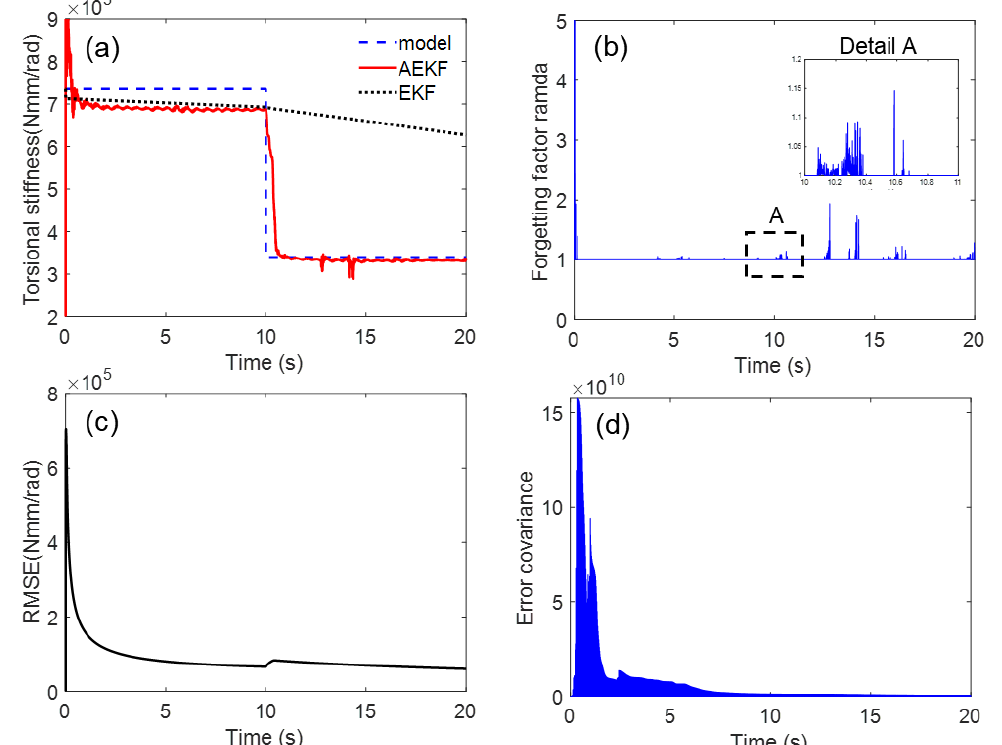
Figure 5. Simulation result for tracking sudden torsional stiffness drop: ( a ) time response of torsional stiffness, ( b ) corresponding time history of forgetting factor, and ( c ) RMSE, ( d ) convergence history of covariance.